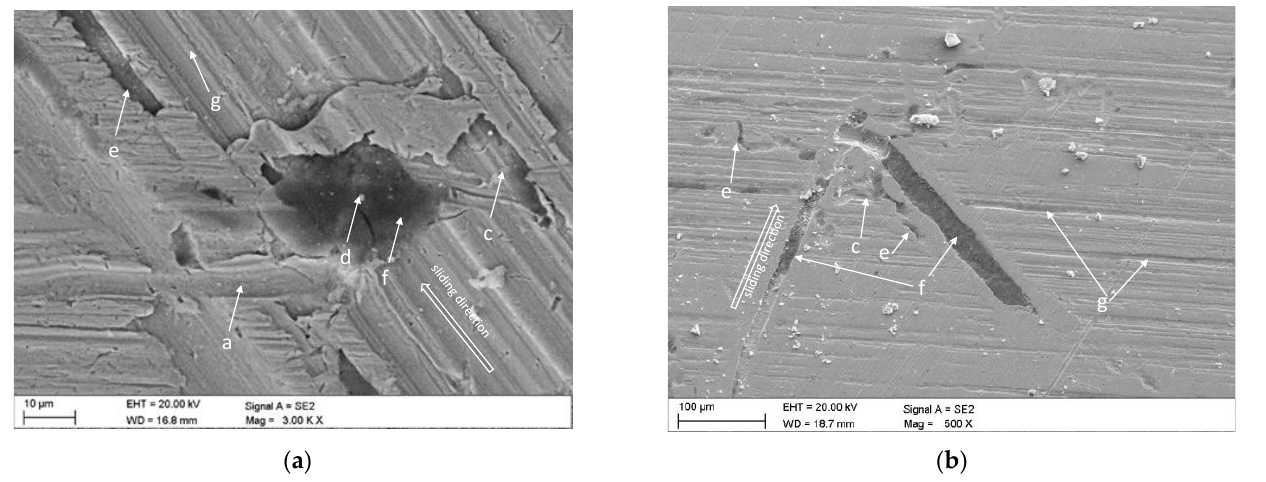
Figure 7. Examples of delamination of the surface of WRS_400_I steel in the area of contact between the sanding marks and the micro-cut caused by coal abrasive; symbols: a—grooves, c—delamination, d—debris, e—surface crack (exfoliation), f—coal-filled surface damage, g—sanding marks.